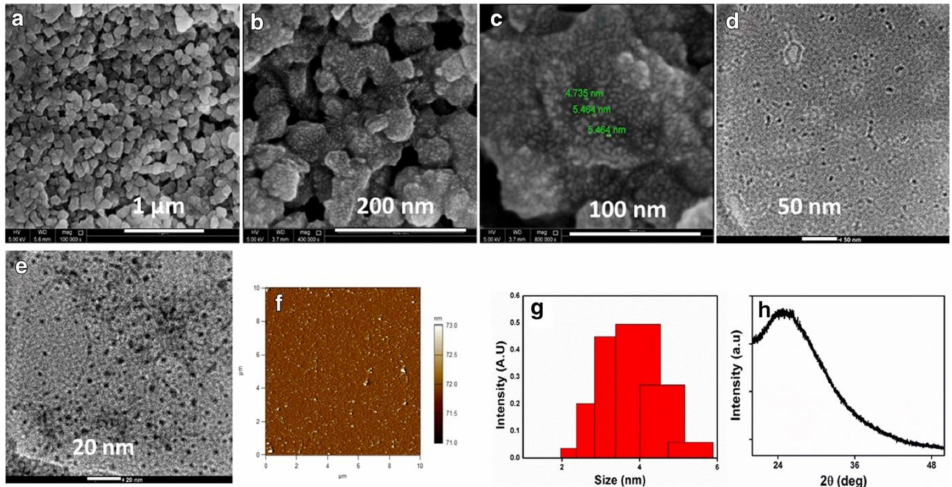
Figure 7. ( a – c ) SEM of CQDs; ( d ) and ( e ) TEM of CQDs; ( f ) CQDs size distribution; ( h ) XRD of CQDs. Reproduced with permission from ref. [105], published by Springer Open,